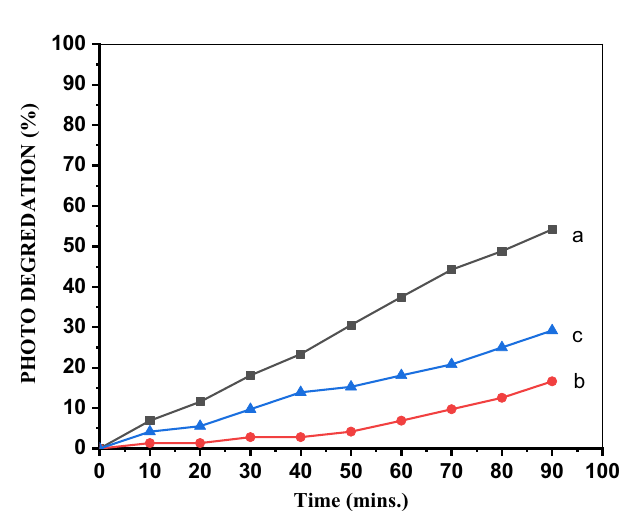
Figure 9. Photo degredation for ( a ) ZnO, ( b ) ZnO/5PVA, ( c ) ZnO/7PVA and ( d ) ZnO/10PVA calcined at 300 °C of MO.